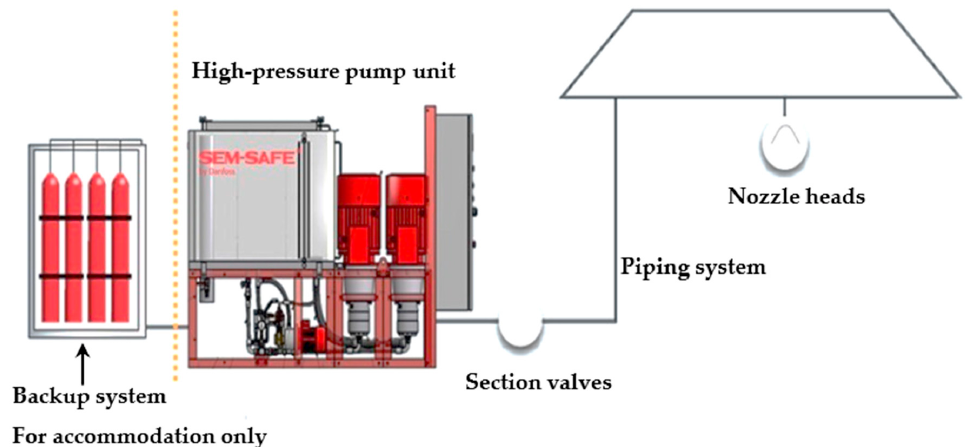
Figure 27. SEM-SAFE water mist system main components [47].